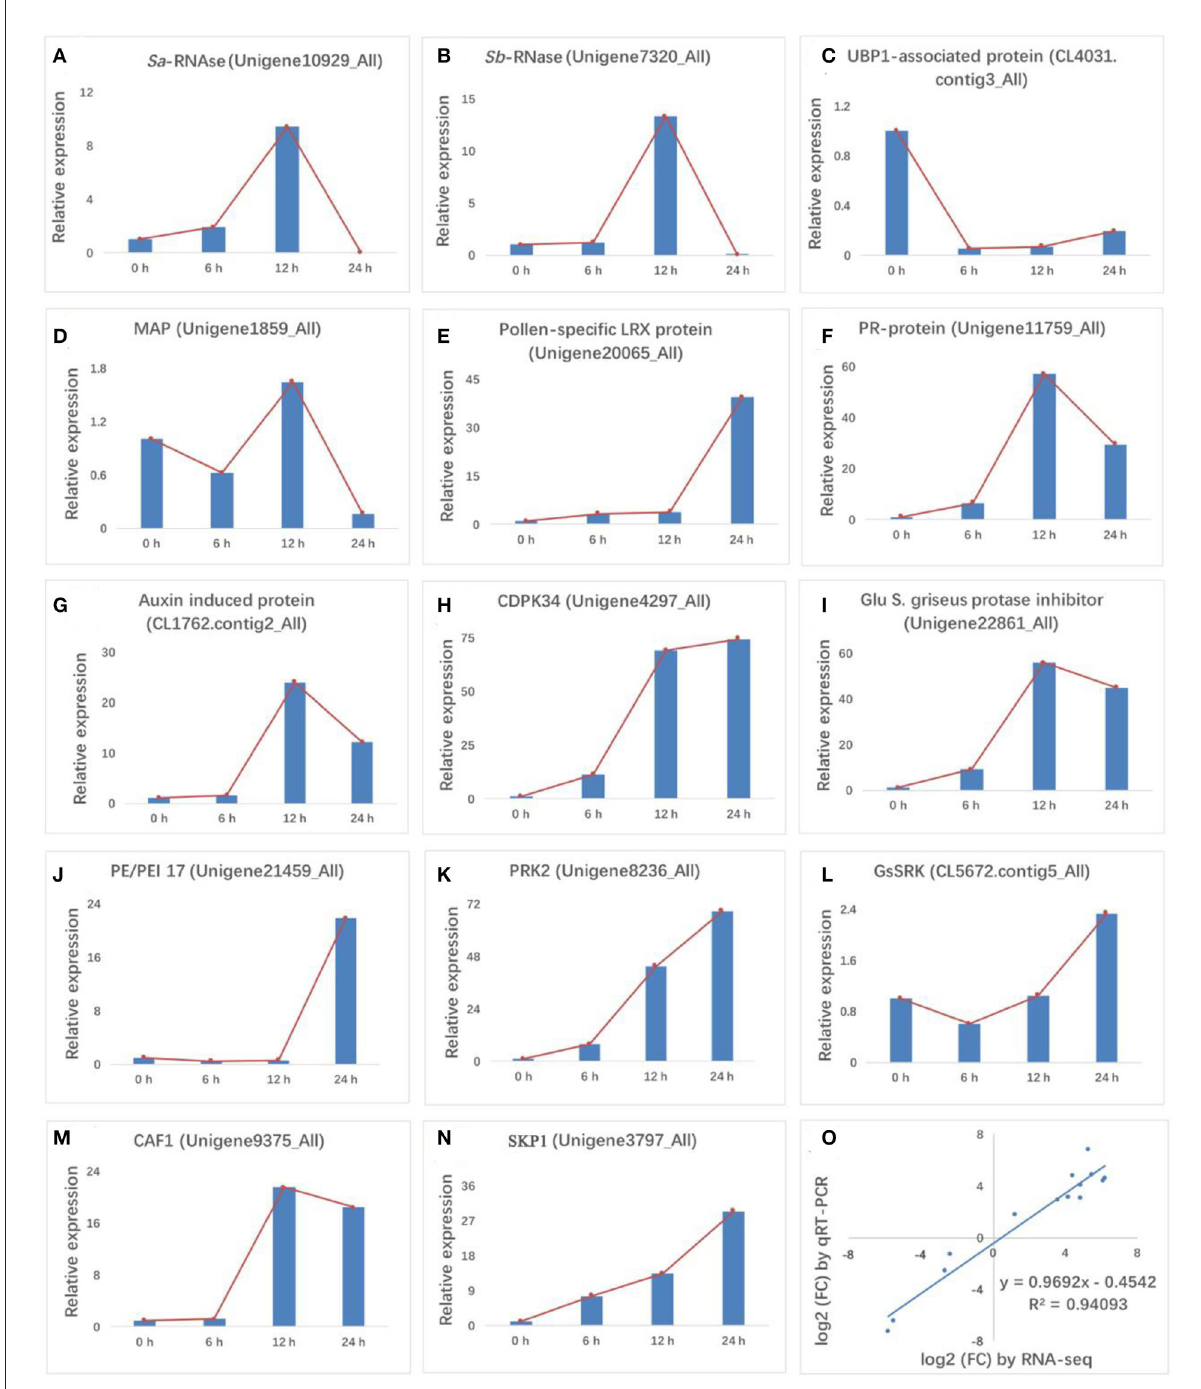
FIGURE3 RT-qPCR validation of 14 differentially expressed genes (DEGs). (A,B) S-RNase , (C) cell death, (D) microtubule binding, (E) pathogen response, (F,G) hormone signaling, (H) CDPK signaling, (I) enzyme inhibitor activity, (J) cell wall, (K,L) pollen development, (M) RNA degradation, and (N) ubiquitin-mediated proteolysis were validated for gene expression levels at 0, 6, 12, and 24 HAP. (O) Comparison of fold-changes in gene expression (24 HAP/0 HAP) between RNA-Seq (x-axis) and RT-qPCR (y-axis) data. Both data were log 2 -transformed. In charts, red lines in (A–N) indicate the expression trend of each gene at the four pollination